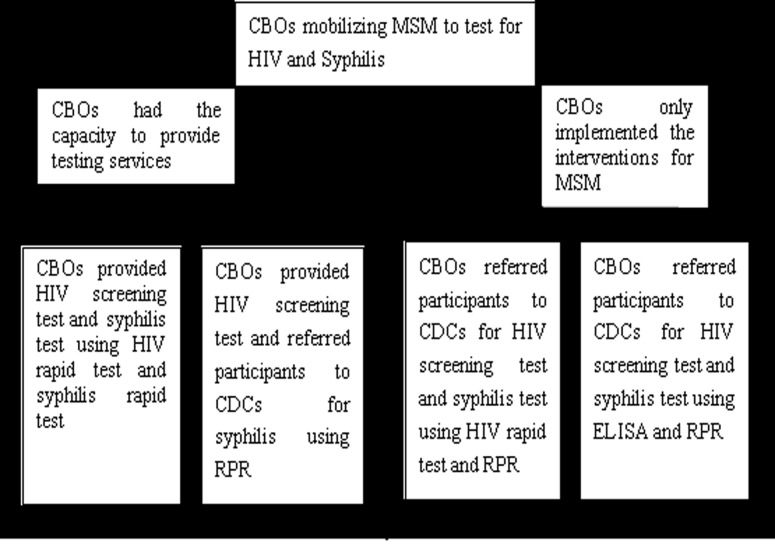
HIV screening and syphilis testing procedures.